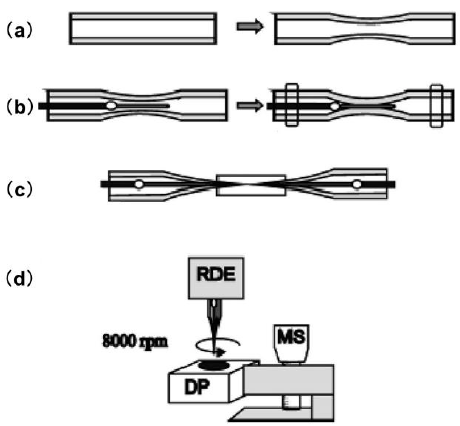
Figure 3. Protocol for microelectrode fabrication. ( a ) Quartz capillary thinning following laser exposure and pulling; ( b ) Insertion and sealing of a Pt wire in a quartz capillary; ( c ) Quartz capillary pulling process; ( d ) Mechanical micropolishing using rotating disk electrode (RDE), microsrew (MS), and diamond coated paper (DP). Copyright (2011) American Chemical Society.